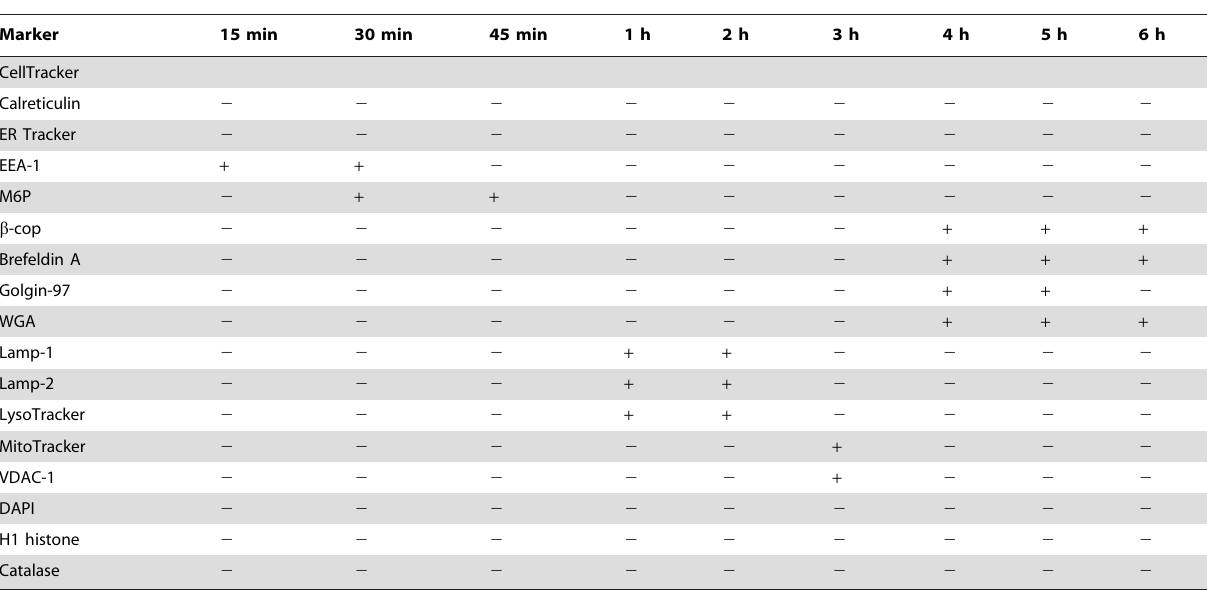
Table 3. Summary of intracellular V trafficking.